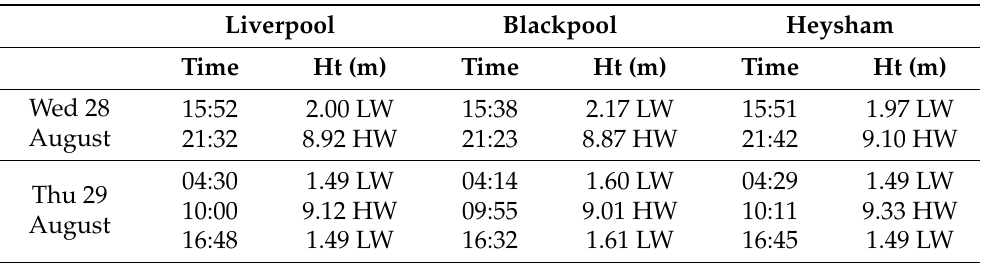
Table 1. Tidal predictions for Liverpool (Gladstone Lock), Blackpool and Heysham (from POLTIPS 2009) for 28–29 August